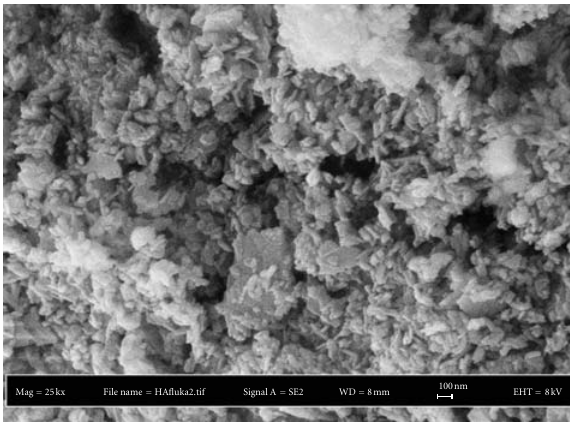
Figure 2: Morphology of HA particles.